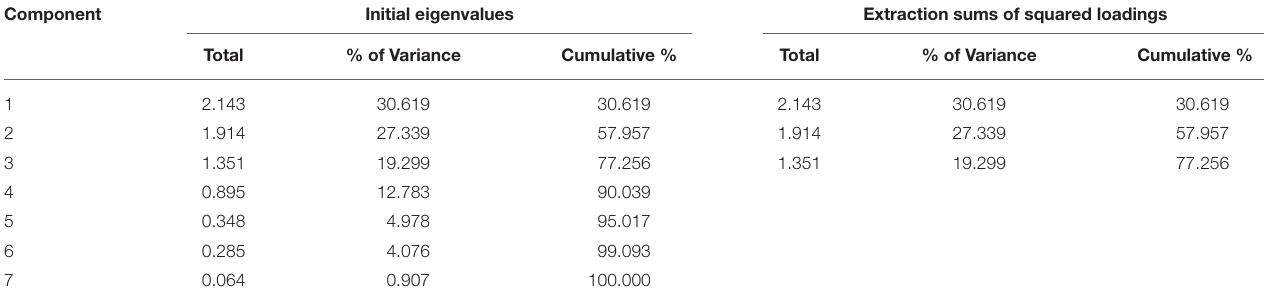
TABLE 1 | Eigenvalues and percentage of intertia explained by each principal component. Component Initial eigenvalues Extraction sums of squared loadings Total % of Variance Cumulative